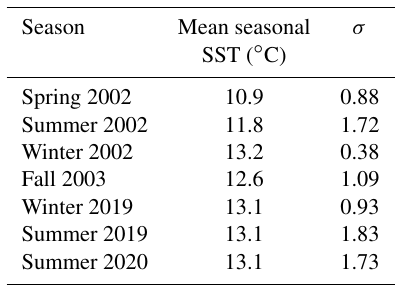
Figure 8. Box plot showing the range of standardized ratio of inner- calcite thickness to shell length in archival and modern specimens. White diamond denotes mean. Table 2. Seasonally averaged SST ( ◦ C) for the specific collection season of each mussel ( n = 40 over eight collection dates across seven different seasons) and standard deviation for each calendar season of the study period. Spring: March through May; summer: June through August; fall: September through November; winter: November through